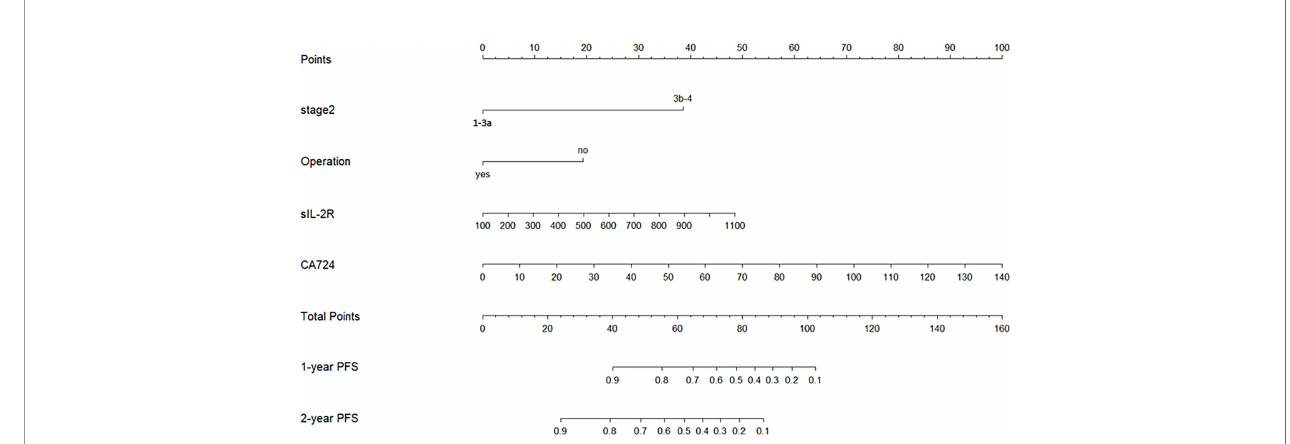
FIGURE 3 | Nomogram-based prognostic model for NSCLC patients of Qi-Yin de fi ciency pattern with long-term CHM treatment ( Stage 2 , TNM stage; Operation , operation history; 1-year PFS , predicted probability of PFS of 1 year; 2-year PFS , predicted probability of PFS of 2